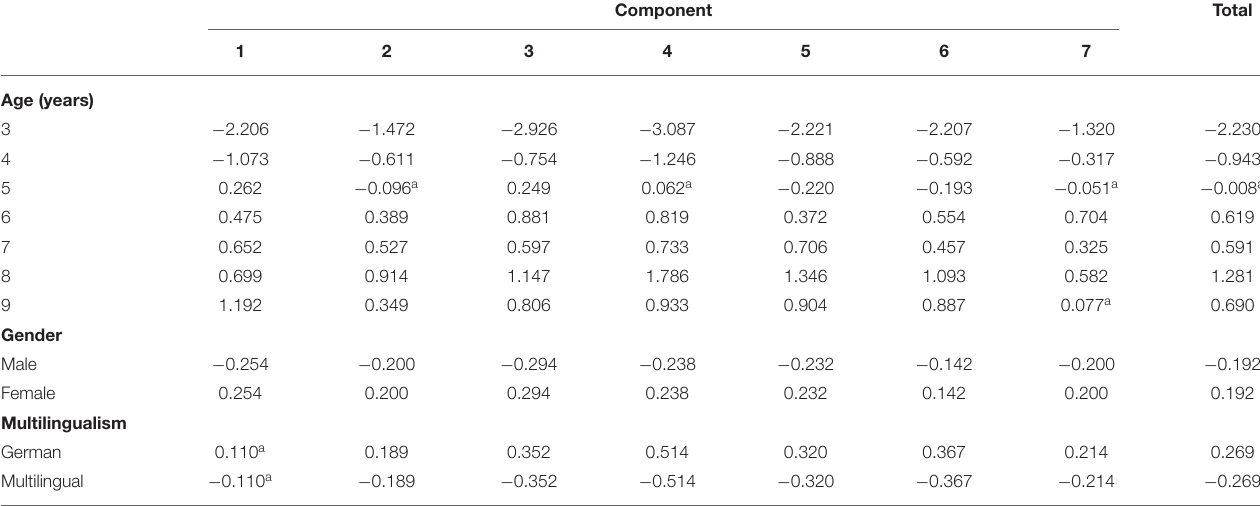
TABLE 7 | Person parameter deviance estimates from zero of age groups, gender, and multilingualism for the components and the total scale of the ATEM 3–9. Component